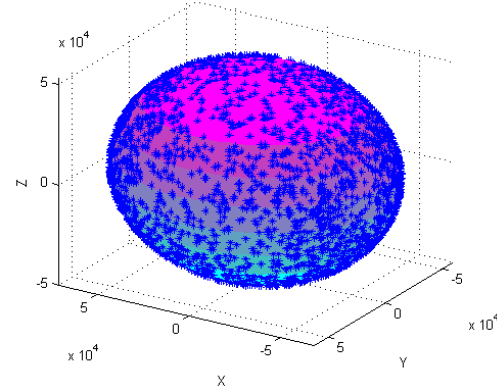
Figure 11. Optimal ellipsoid fitting (EF8).